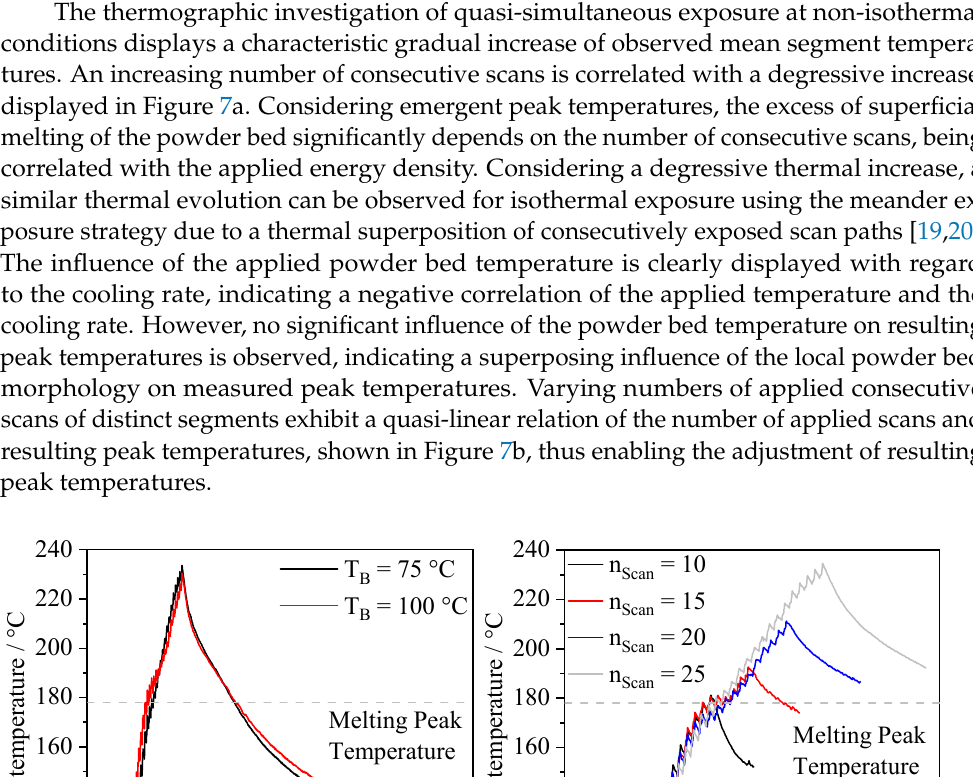
Figure 8. ( a ) Influence of the exposure sequence of a 10 × 10 mm 2 cross-section on resulting peak temperature values; ( b ) Spatial representation of the fractal exposure sequence of distinct segments. Given the applied process parameters, fractal sequencing allows for the reduction of thermal superposition with regard to observed peak temperatures. Considering the fractal structure of the applied exposure sequence, a local, significant increase of peak tempera- tures can be observed, being correlated with the local meander-shaped sequence of the